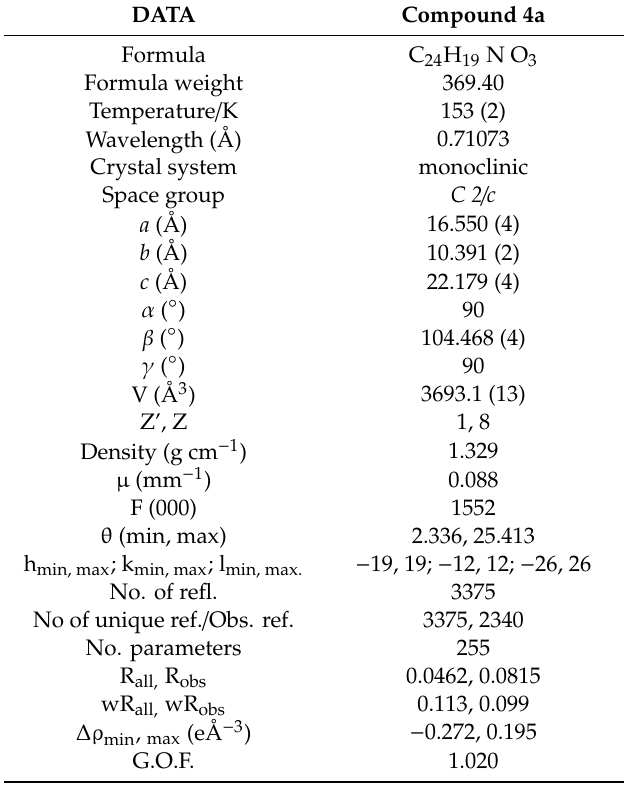
Table 2. Single crystal data collection and refinement for title compounds 4a